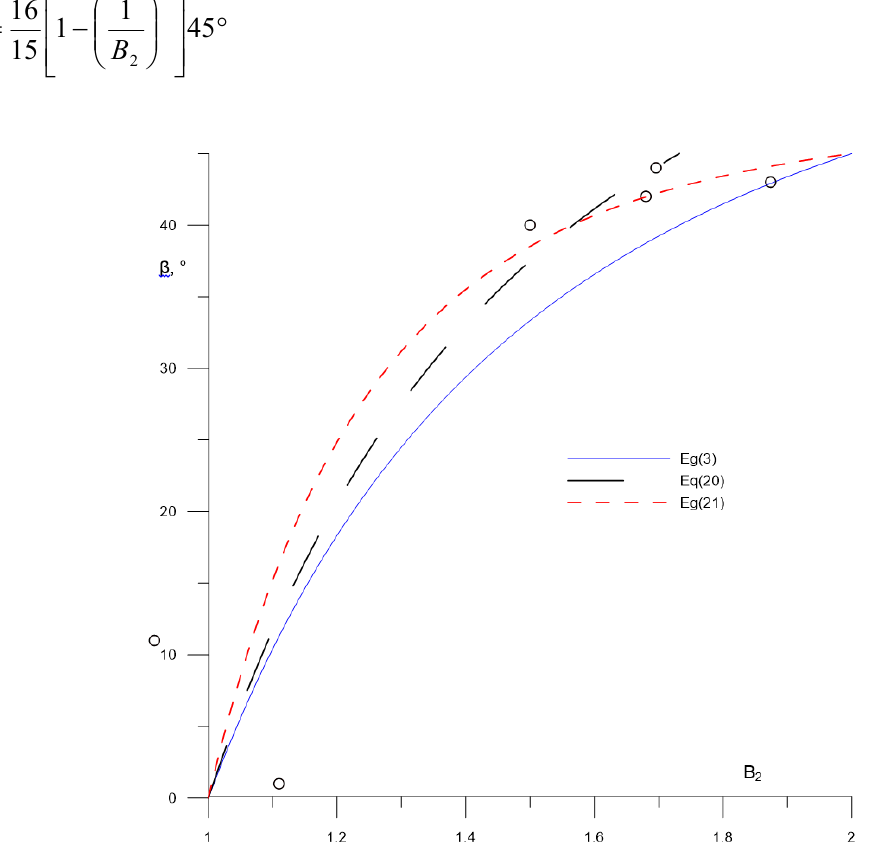
Figure 4: The relationship between the angle β and the parameter B 2 according to different